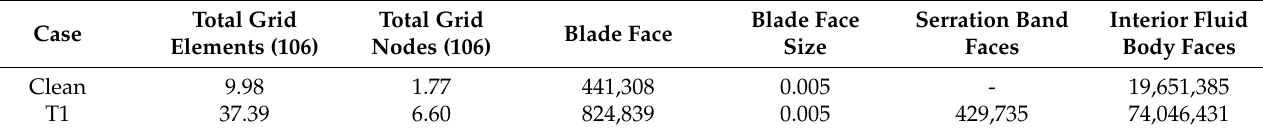
Table 6. Details of grid topology used are used for the clean and the modified